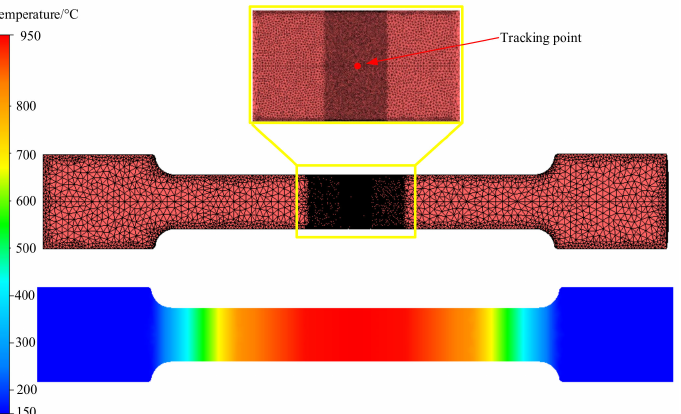
Figure 7. Mesh size distribution and temperature distribution at 950 ◦ C along the sample length